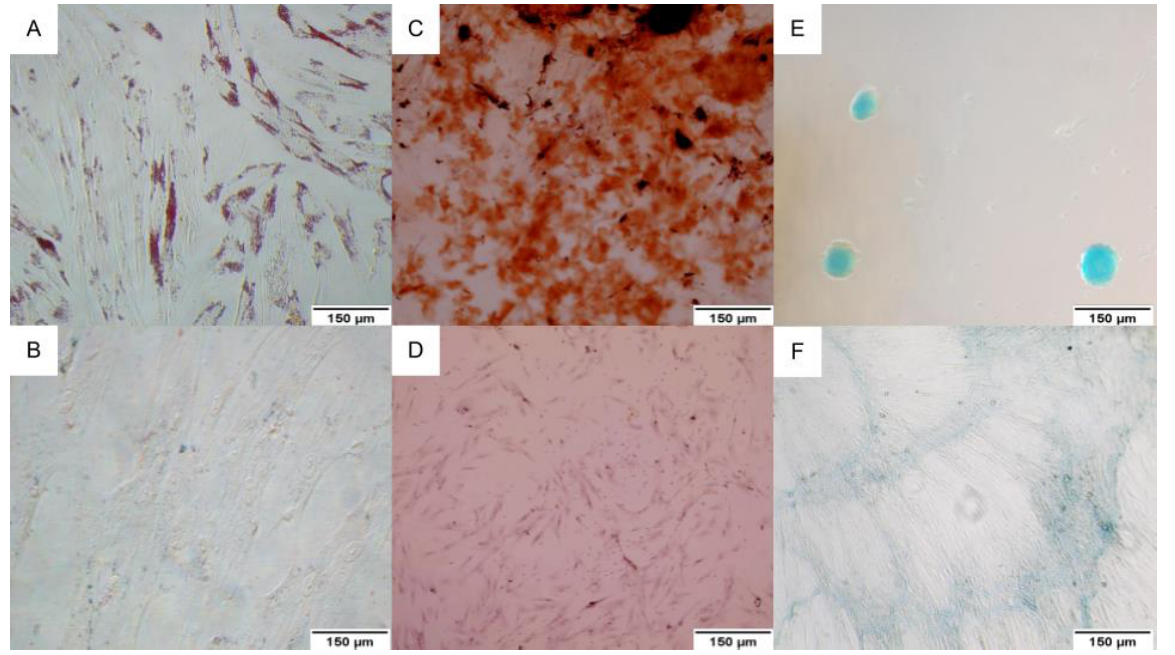
Figure 2. Trilineage differentiation. ( A ) WJ-MSC differentiated into adipocytes presenting lipid vacuoles stained with oil red O; ( B ) Control of undifferentiated WJ-MSC stained with oil red O; ( C ) WJ-MSC differentiated into osteoblasts showing mineralization stained with alizarin red; ( D ) Undifferentiated WJ-MSC stained with alizarin red; ( E ) WJ-MSC differentiated into chondroblasts with a production of proteoglycans stained with alcian blue; ( F ) Undifferentiated WJ-MSC stained with alcian blue. Image obtained through inverted optical microscopy, 100 × (Axio Vert. A1, Zeiss, Oberkochen, BW, Germany).